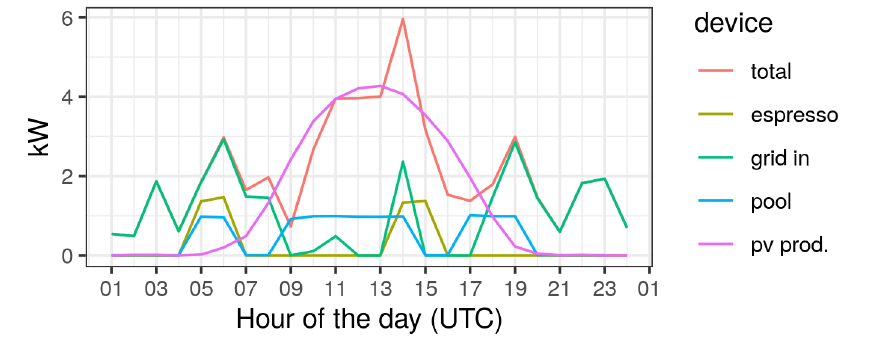
Figure 19. Power peaks prior to Smart Home Energy Management